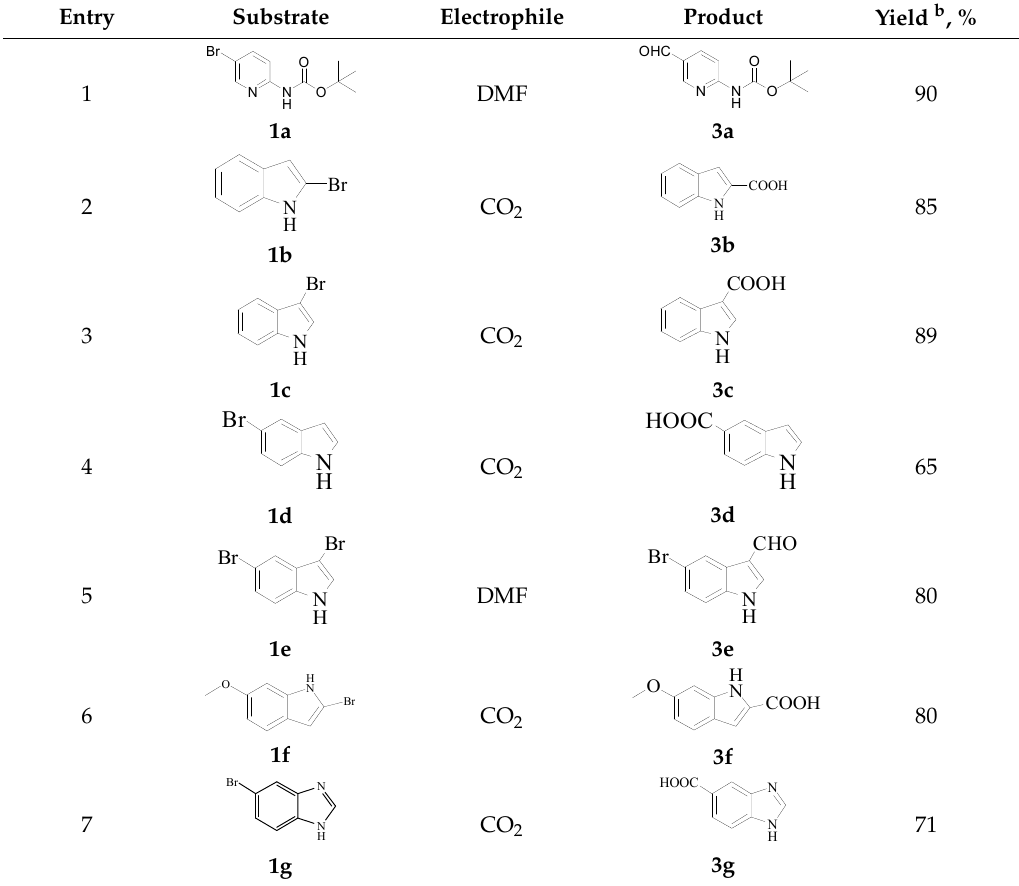
Table 3. Br–Mg (Li) exchange on bromopyridines bearing an acidic proton a .